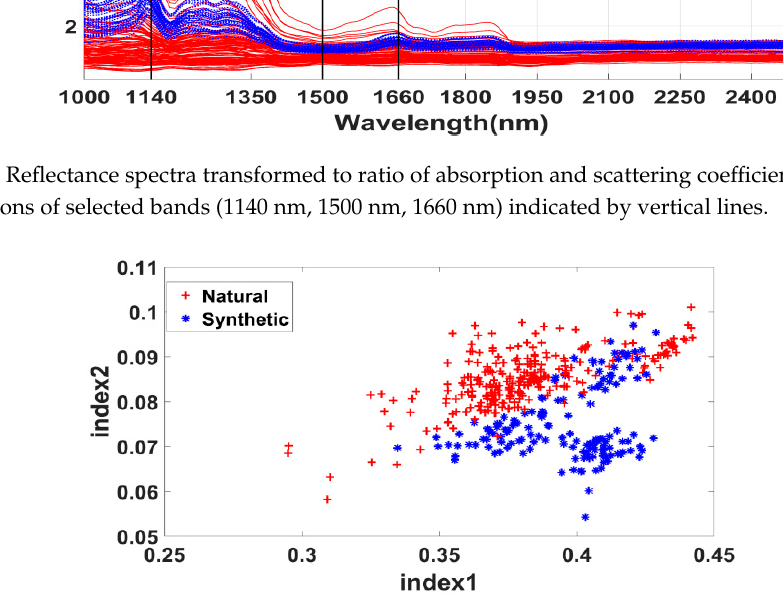
Figure 9. Scatterings of all samples from both classes in the space of normalized indexes.